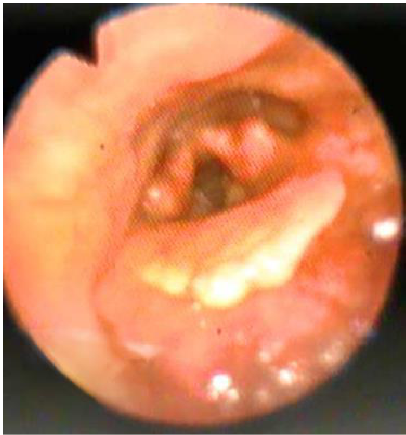
Figure 1. Nasopharyngosopic view of patient with grade 4